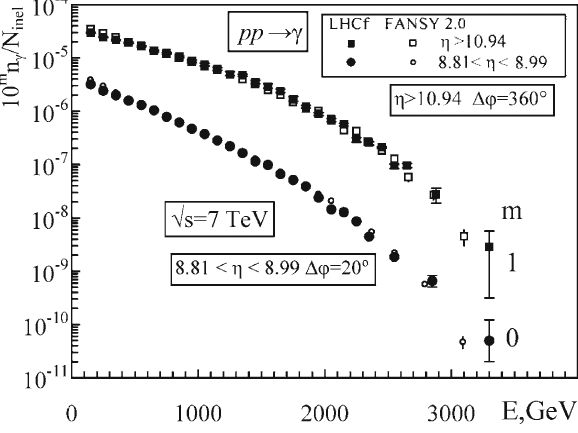
Fig. 8 LHCf[38]andFANSY2.0 γ -ray n γ / N inel / GeVenergyspectra at η > 10 . 94, Δφ = 360 ◦ (upper symbols) and 8 . 81 < η < 8 . 99, Δφ = 20 ◦ (lower symbols) multiplied by 10 m , where m = 1 and 0, √ s = 7 respectively, at